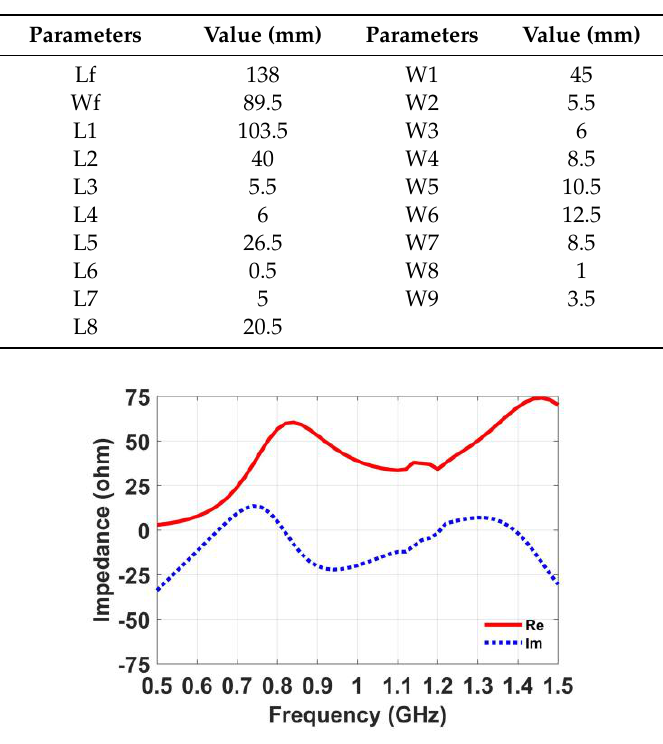
Figure 9. Input impedance of the proposed UHF antenna. Table 1. Design parameters of the proposed UHF antenna.